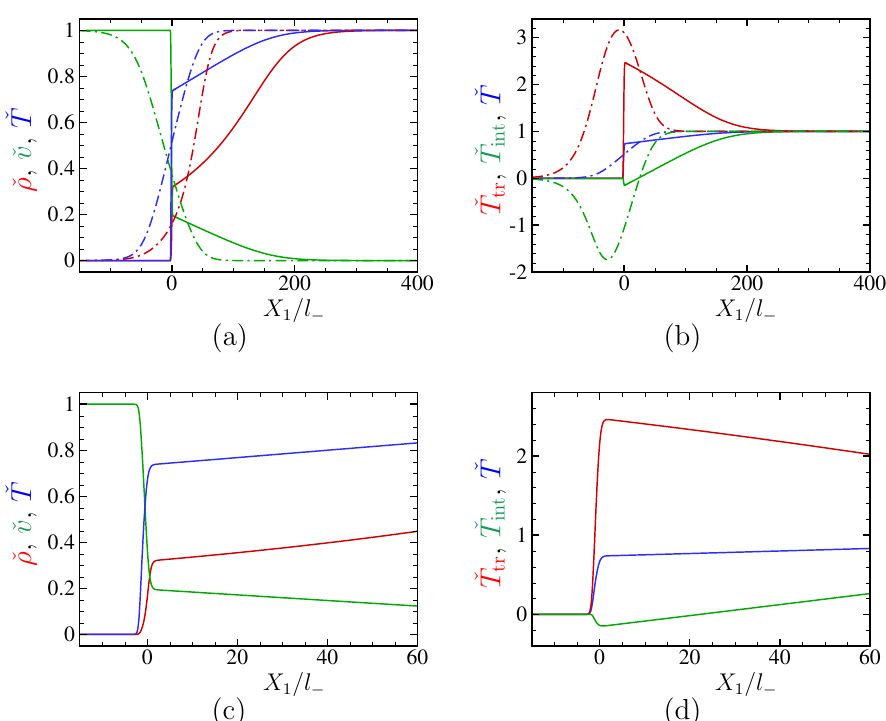
Figure 18. Profiles of ˇ ρ , ˇ v , ˇ T , ˇ T tr , and ˇ T int in the case of CH 4 gas at M − = 5. ( a , c ) ˇ ρ , ˇ v , and ˇ T ; ( b , d ) ˇ T tr , ˇ T int , and ˇ T . Panels ( c , d ) are, respectively, the magnified figures of panels ( a , b ). See the caption of Figure